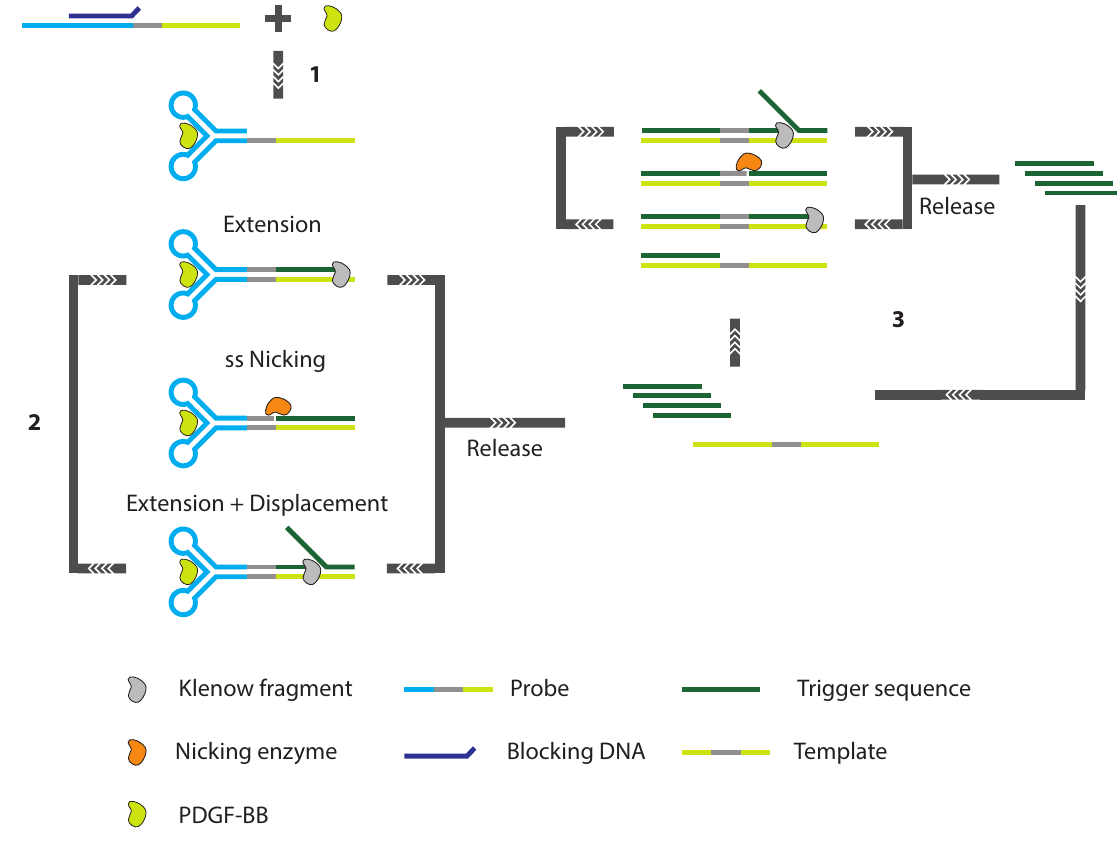
Figure 18. The exponential amplification reaction based assay involves three principal steps: ( 1 ) target-aptamer binding and blocker DNA dissociation, ( 2 ) linear strand displacement amplification, and ( 3 ) exponential amplification reaction. It is the binding of the target protein, PDGF-BB, that triggers a conformational change of the extended aptamer. This conformational change enables a cascaded amplification of the trigger sequence that ultimately results in a detectable signal